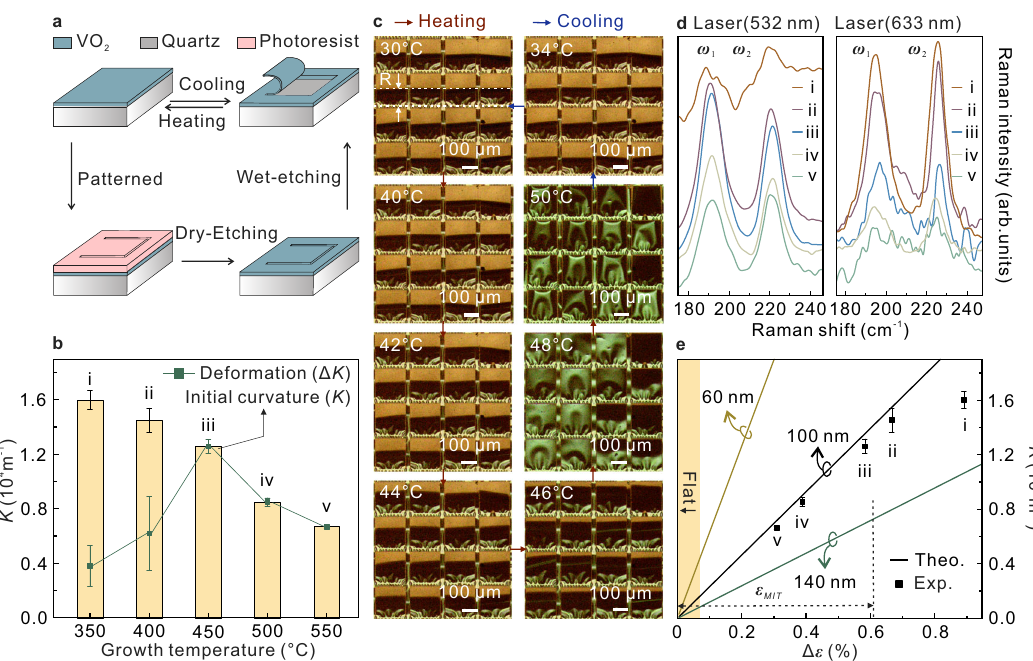
Fig. 3 | Strain and deformation of rolled-up SW. a Fabrication process of the rolled-up SW. b Initial curvature ( K ) of rolled-up SW with different growth tem- peratures and corresponding deformation ( 4 K ) during heating. i (350°C), ii (400°C), iii (450°C), iv (500°C), and v (550°C). The corresponding error bar represents standard deviation. For calculation, different rolled-up structures on each sample were measured, and the numbers ( n ) of the measured rolled-up structures are n i =1598, n ii =982, n iii =795, n iv =690, and n v =682 (one measure- ment for each rolled-up structure). c Microscope image of sample iii at different